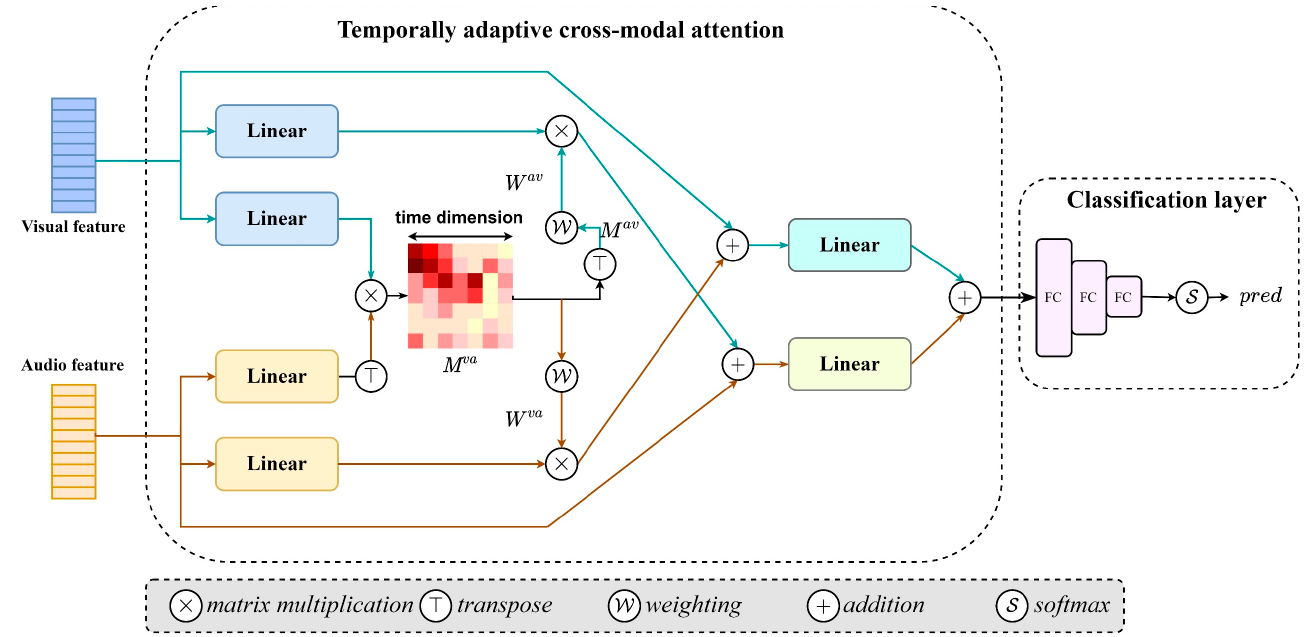
Figure 4. Structures of the proposed TACMA and classification layer.